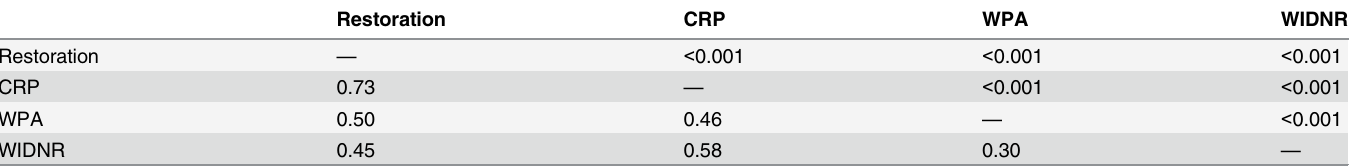
Table 2. Analysis of similarities (ANOSIM) matrix for managed grassland plant communities among four planting types.